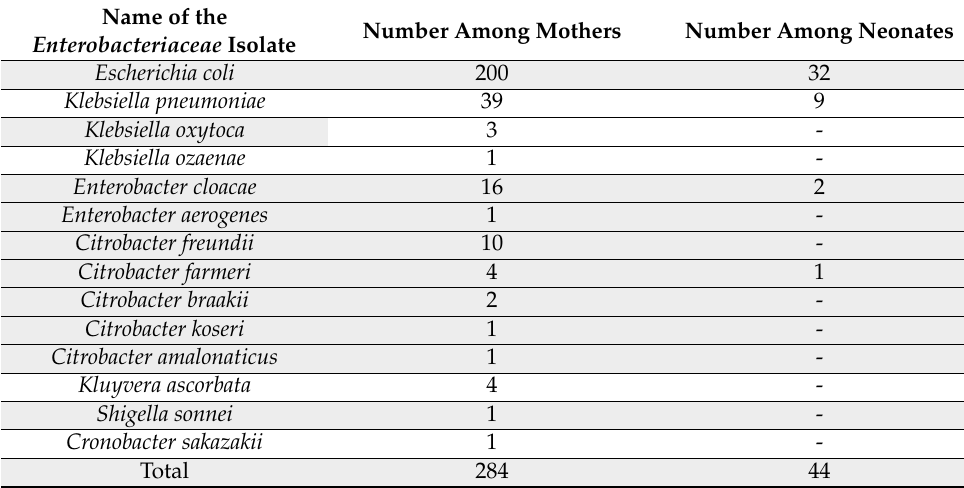
Table 3. The distribution of species among mothers and